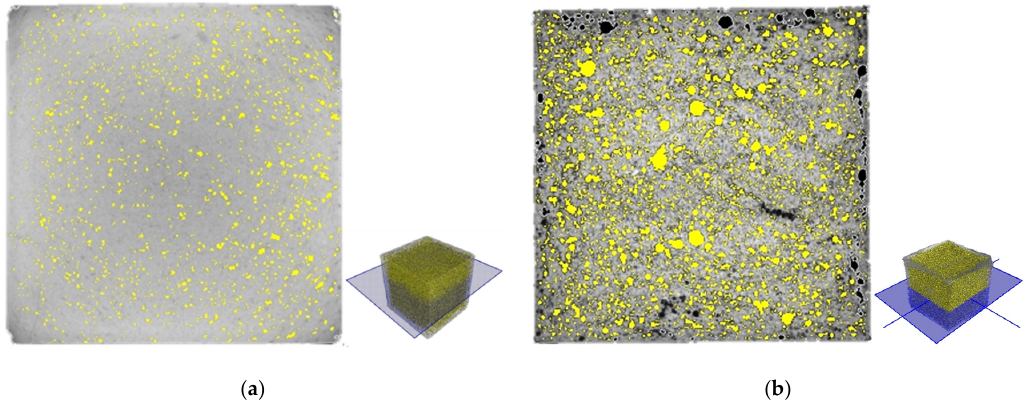
Figure 8. Cross-sectional images of ( a ) PCM1-1 and ( b ) PCM3-3 from the X-ray CT analysis.